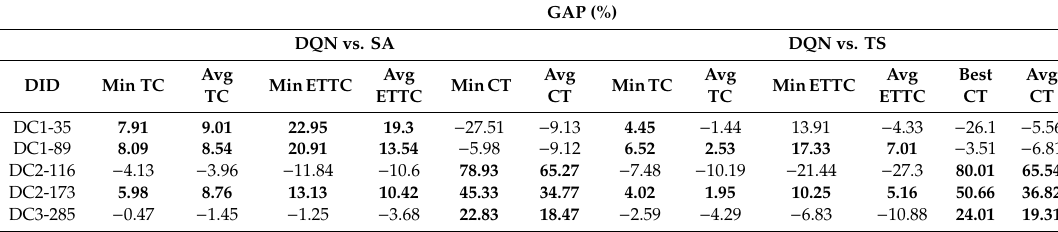
Table 10. Performance gap between DQN, SA, and